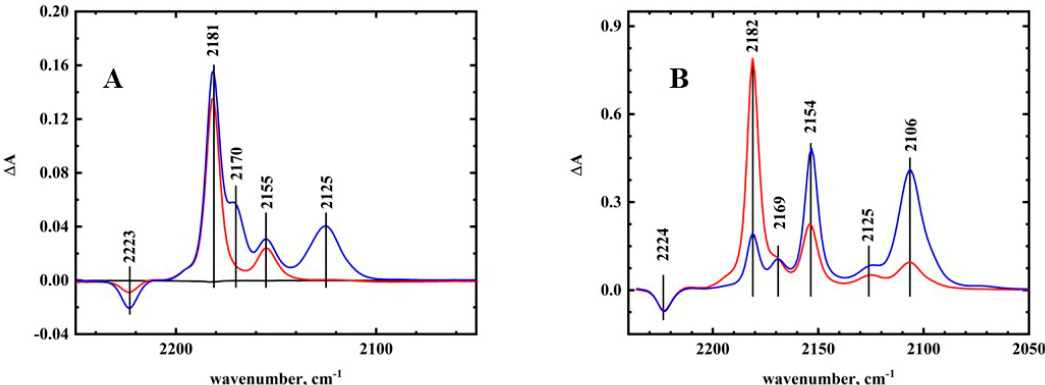
Figure 6. Infrared spectroelectrochemistry of TCNQ. ( A ) In BMImNTf 2 . Initial difference spectrum (black); TCNQ − (red); TCNQ 2 − (blue). ( B ) In 50% BMImPF 6 / acetonitrile. TCNQ − (with some TCNQ 2 − ) (red); TCNQ 2 − (blue). Electrolyte: 0.10 M TBAP.